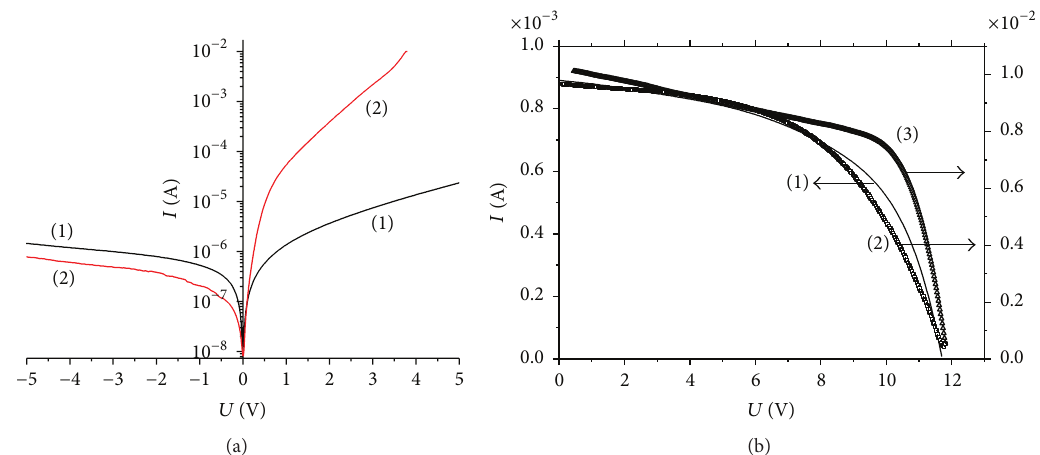
Figure 7: Dark (a) and light (b) 𝐼 - 𝑈 characteristics of MJ Si-SC: (1)—initial curve, (2)—after RIE etching; and (3)—after RIE + RF treatments.